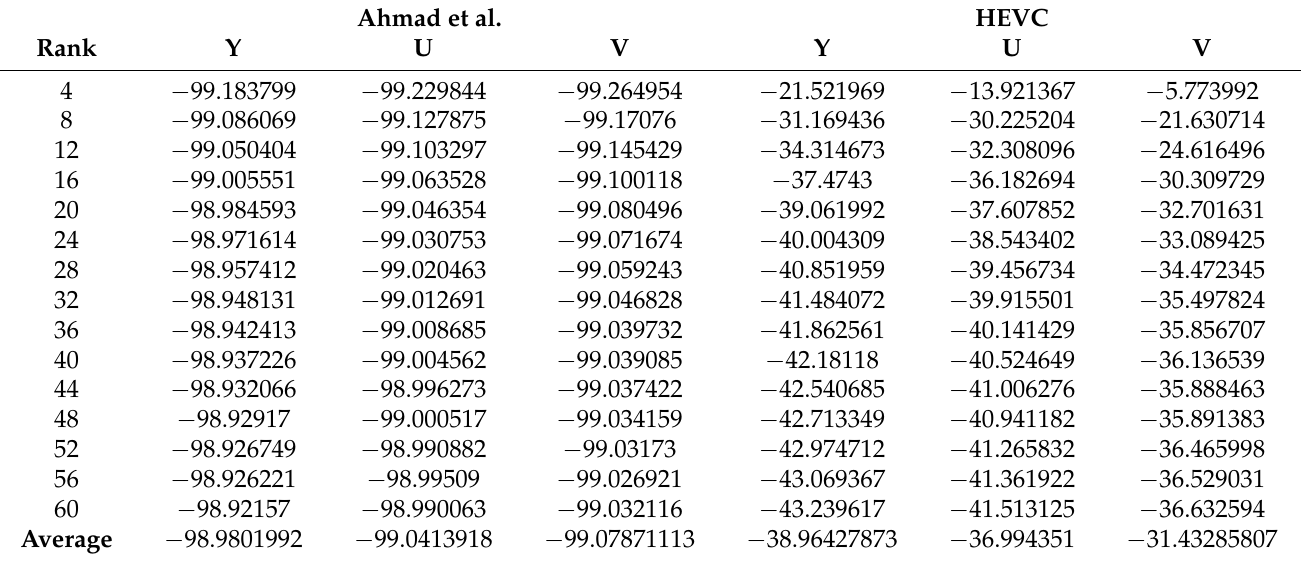
Table 4. Bjontegaard percentage rate savings for the proposed compression scheme with respect to Ahmad et al. and HEVC codec (negative values represent gains) on Fountain-Vincent2 data.